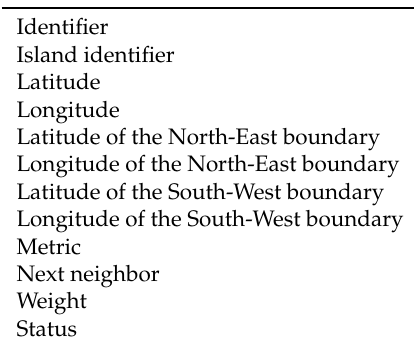
Table 1. Fields of a routing